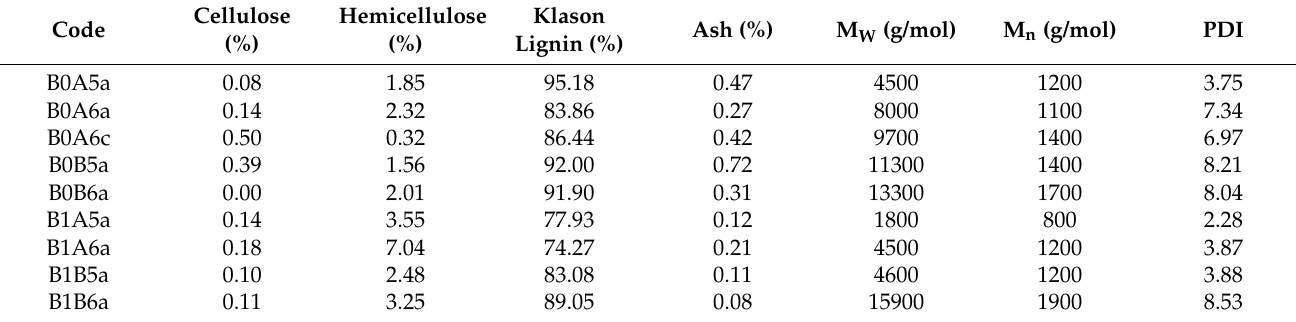
Table 2. Composition of lignin obtained with each organosolv pretreatment. Weight average (M W ), number-average (M n ), and polydispersity index (PDI) of acid-insoluble lignin from birch sawdust were determined after acetobromination.